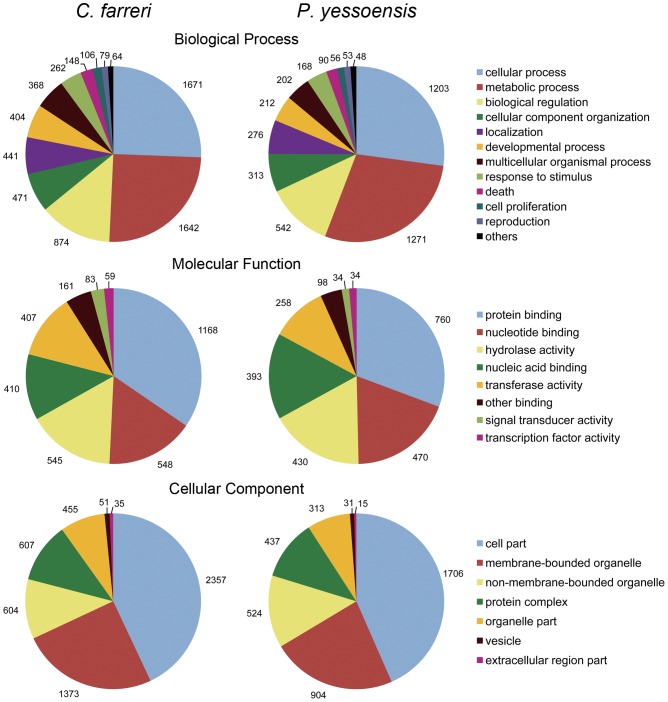
GO comparison between the C.
farreri and P. yessoensis transcriptome.GO analysis was performed at the level 3 for three main categories (cellular component, molecular function and biological process). Note, for the two species, the starting materials used for cDNA library preparation and their normalization histories largely resemble each other, though not completely equivalent (see Table 1 for the details of libraries in comparison).